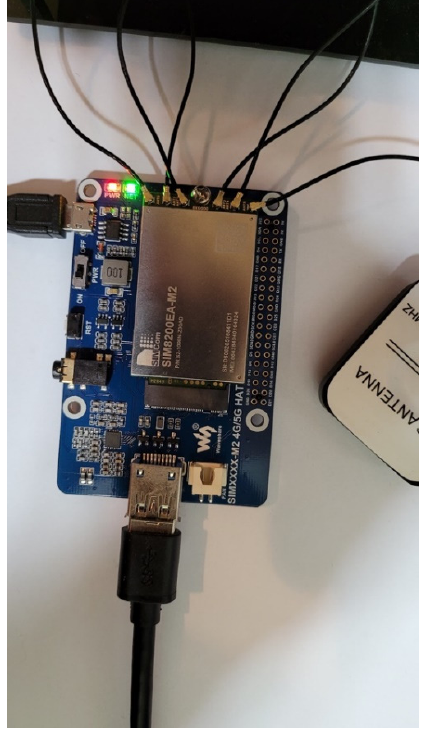
Figure 20. Wiring of SIM8200EA-M2.